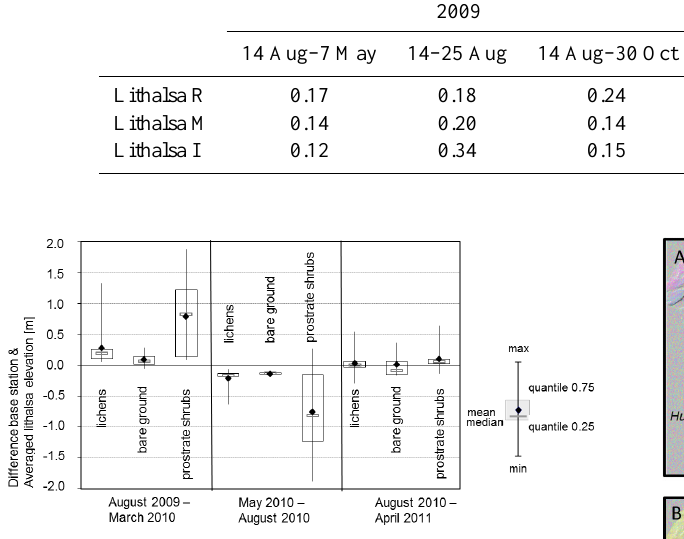
Figure 5. Box plots of surface cover and elevation changes for the three lithalsas, measured between August 2009 and March 2010, between May 2010 and August 2010, and between August 2010 and April 2011, based on all 39 measurement points on the three lithalsas.